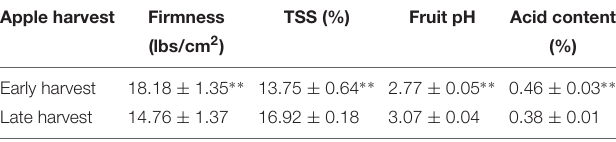
TABLE 1 | Physiological parameters of early and late harvested